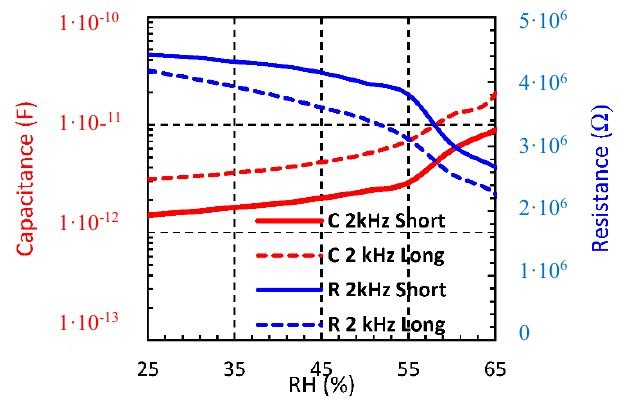
Figure 5. Measured sensors impedance from 25% to 65% RH at different